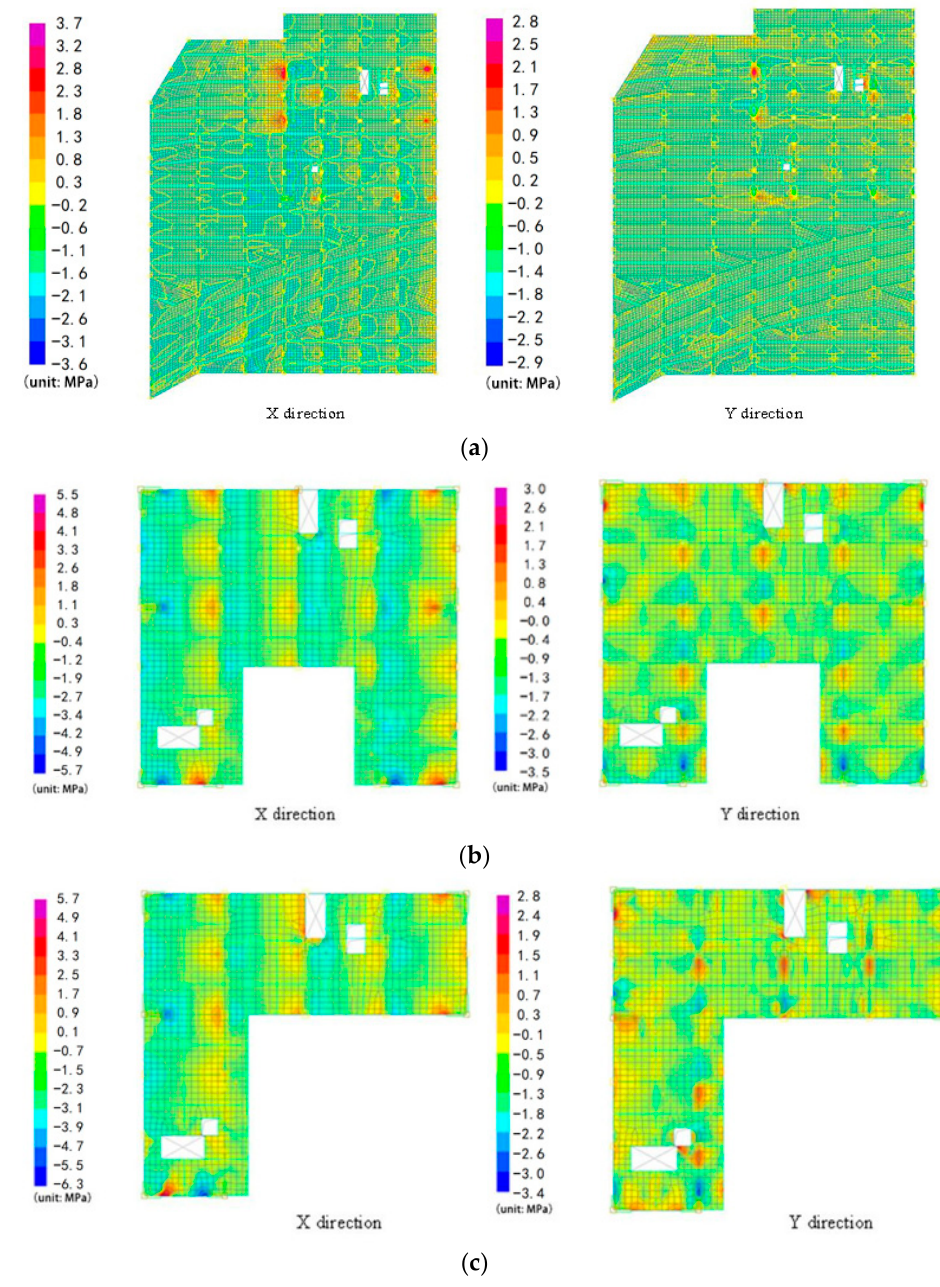
Figure 7. Stress distributions in the floor slabs on the transfer, 6th and 8th storeys (unit: MPa). ( a ) Transfer storey. ( b ) The 6th storey. ( c ) The 8th storey.